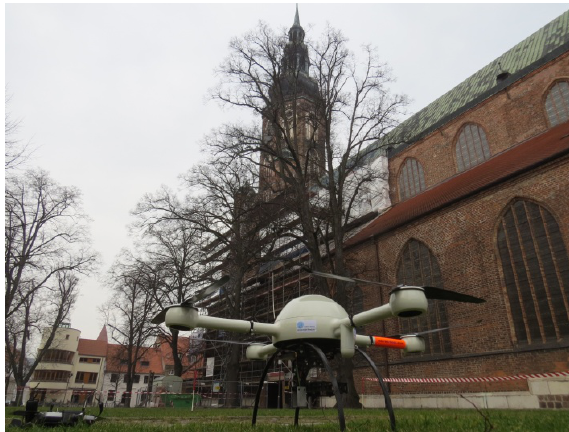
Figure 3. UAS MD4-1000 ready for take-off